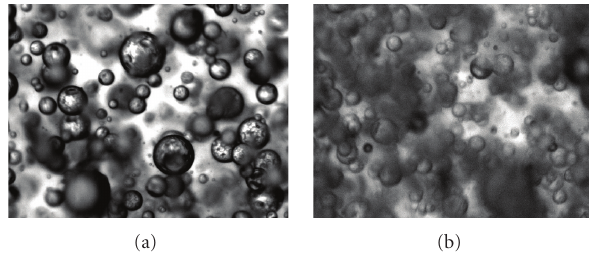
Figure 2: Examples of images, (a) is a very good image, and (b) is an image with low photographic quality.